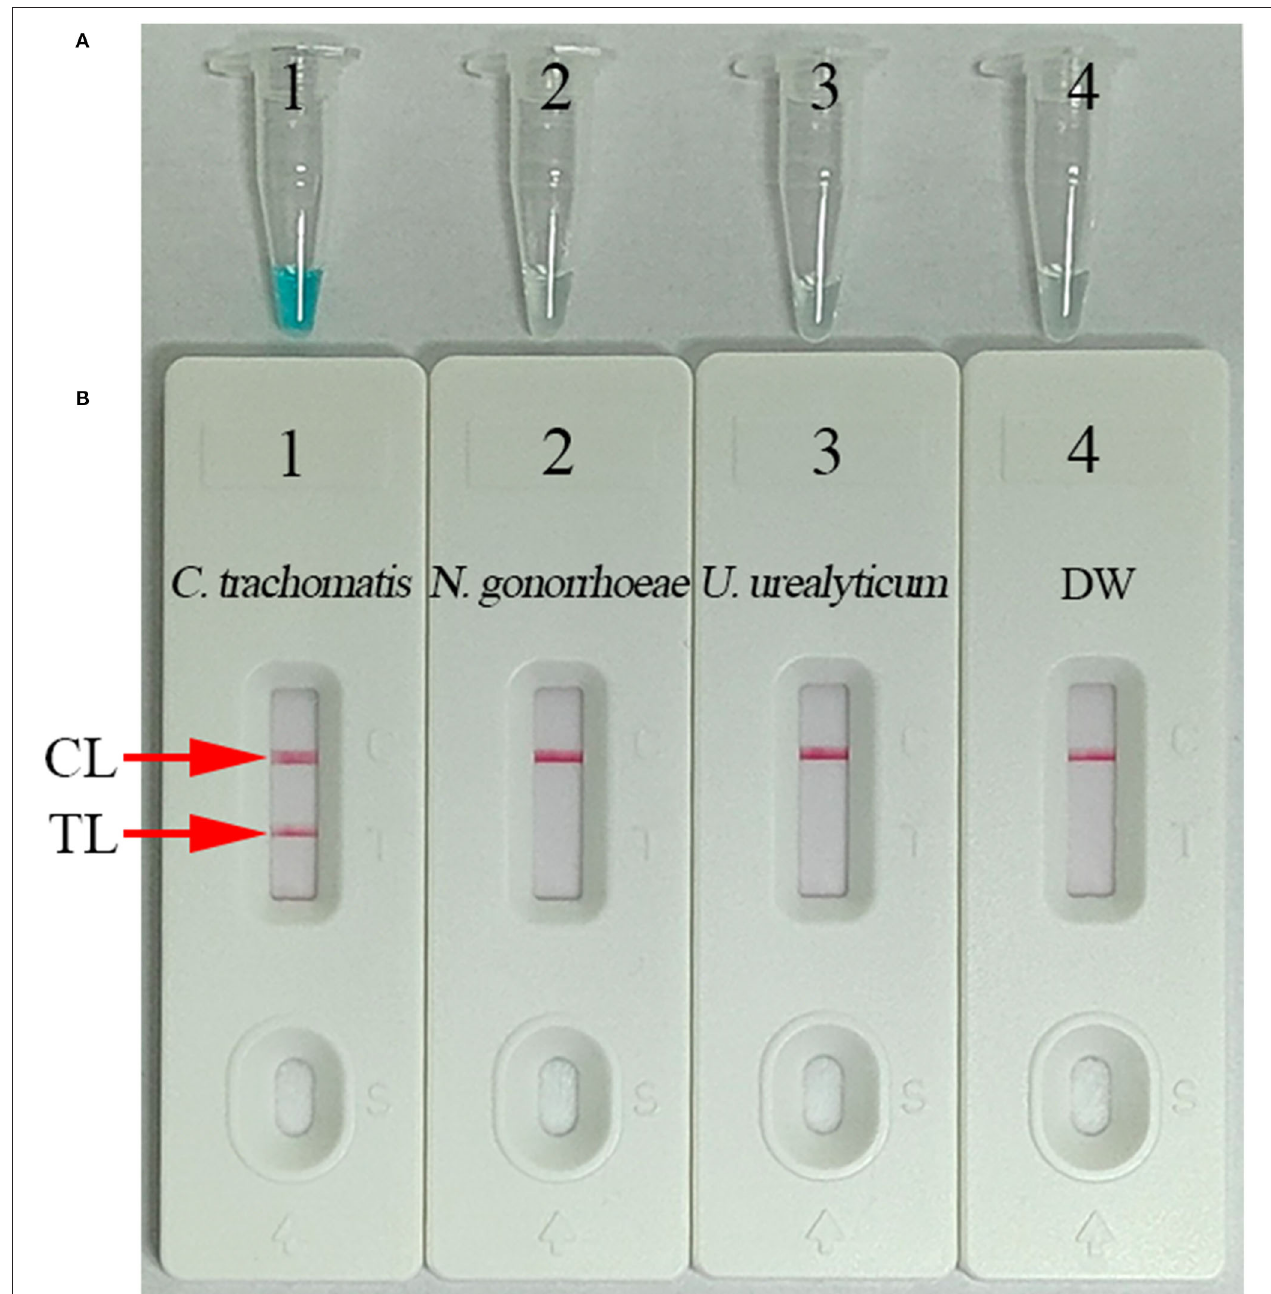
FIGURE 3 | Confirmation and verification of C. trachomatis -LAMP products. C. trachomatis -LAMP products were measured simultaneously through MG regents (A) and LFB (B) . Tube 1/biosensor 1: positive result for the C. trachomatis ompA standard plasmids; tube 2/biosensor 2: negative result for Neisseria gonorrhoeae ; tube 3/biosensor 3: negative result for Ureaplasma urealyticum ; tube 4/biosensor 4: blank control (distilled water, DW). TL, test line; CL, control line.